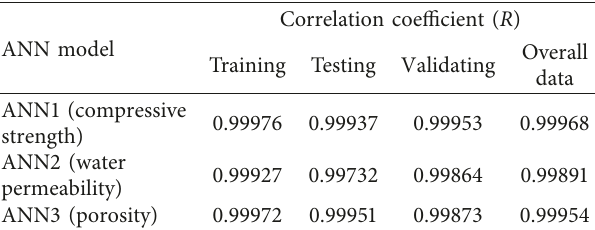
Figure 6: ANN3 model for predicting the porosity of VS-based concrete. Table 2: Correlation coefficients ( R ) of artificial neural network